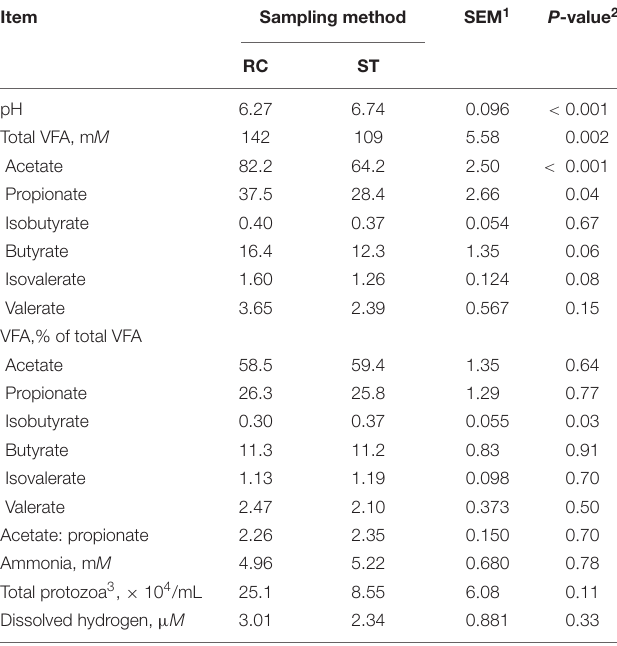
TABLE 1 | Effect of sampling techniques (rumen cannula, RC, vs stomach tube, ST) on rumen fermentation variables in lactating dairy